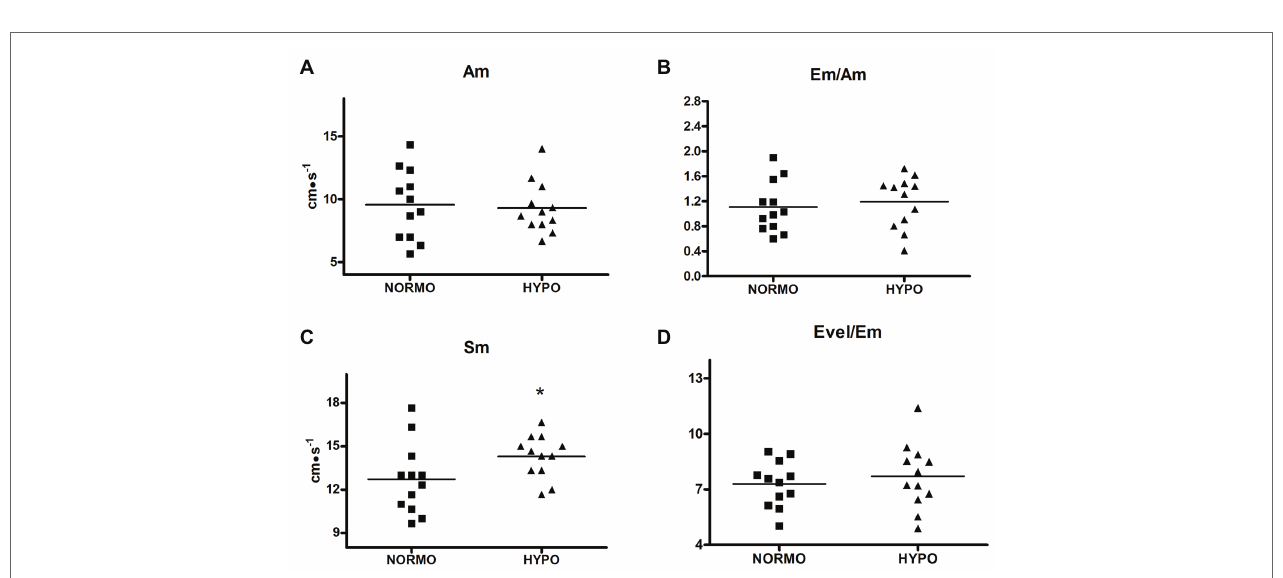
FIGURE 3 | Scatter plot graphs of levels of early transmitral filling peak velocity (Evel, panel A ), late transmitral filling peak velocity (Avel, panel B ), their ratio (E/A, panel C ), and early diastolic mitral valve motion velocity (Em, panel D ) during the recovery from sessions of exercise in normoxia (NORMO) and in normobaric hypoxia with a FiO 2 of 13.5% (HYPO). N = 12. * p < 0.05 vs. NORMO test.